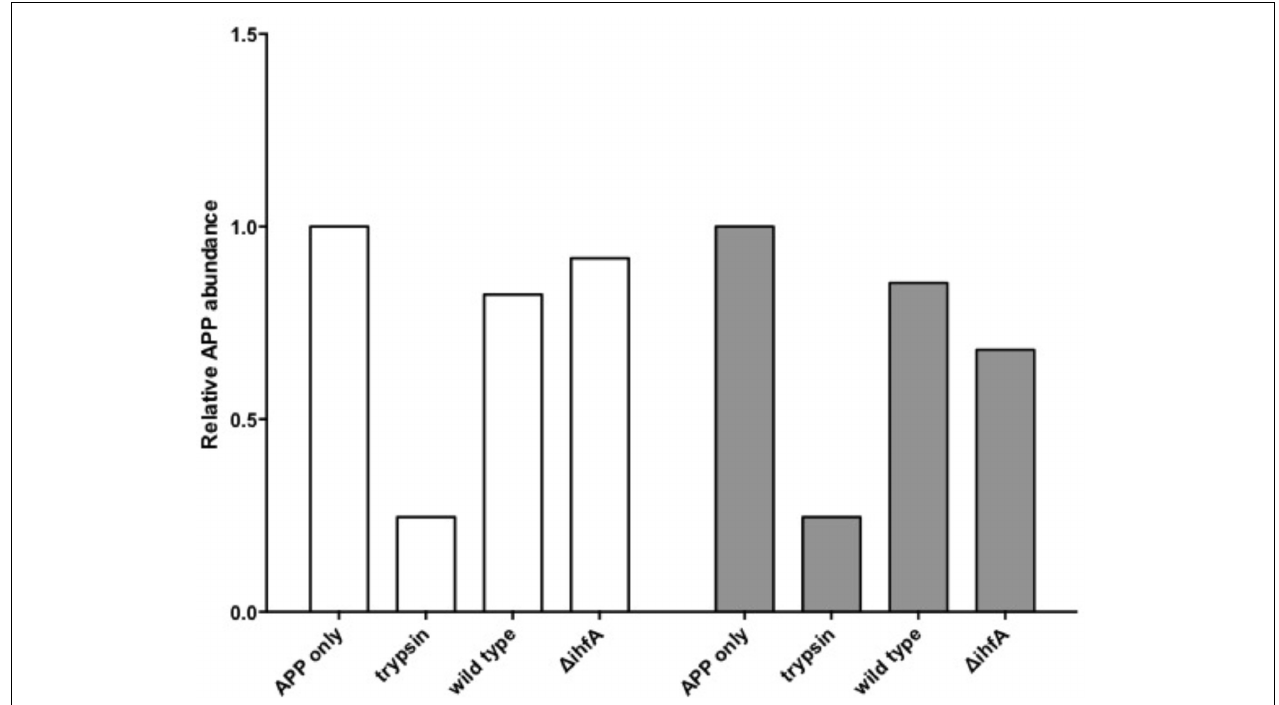
FIGURE 3 | Amyloid precursor protein (APP) degradation by S . Typhimurium. Bars indicate the abundance of intact APP protein relative to the APP only control. Incubation of APP with trypsin functions as the positive control. White bars indicate APP degradation by the Salmonella cell pellet. Gray bars indicate APP degradation by the spent